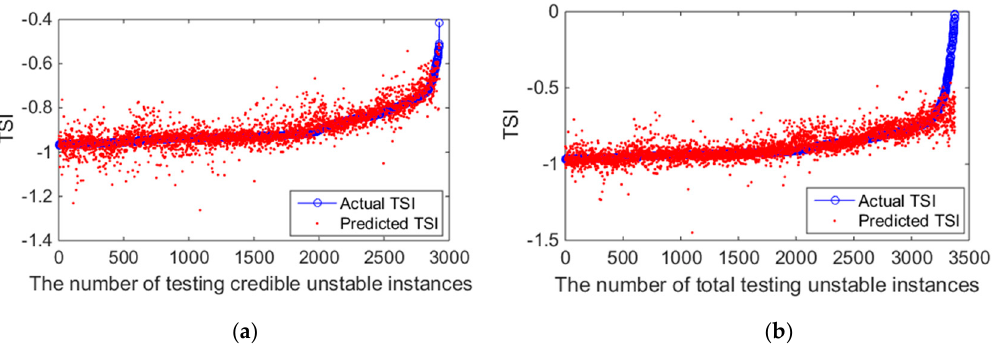
Figure 10. Detailed prediction results for unstable regression model at a response time of 0.50 s: ( a ) detailed prediction results of testing credible unstable instances, MSE = 0.0023; ( b ) detailed prediction results of total testing unstable instances, MSE = 0.0080.